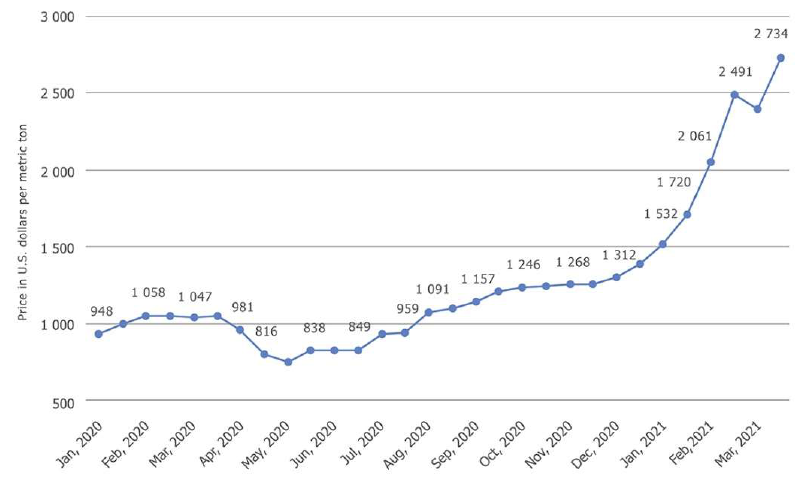
Figure 8. Global price increase in polypropylene (PP) from January 2020 to March 2021 (source: the authors based on [143]).